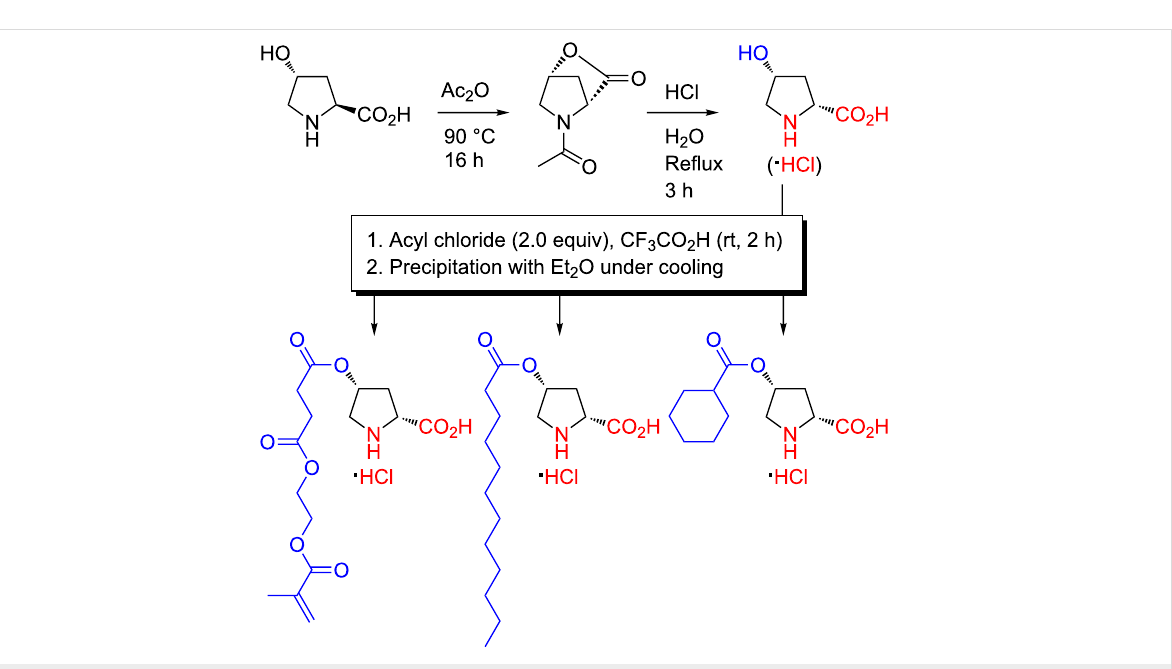
place during those experiments. The literature of such early experimentation on amino alcohol natural products is too volu- minous to justify any exhaustive listing in this work, thus for the purposes herein, it will suffice to point out that the outcome of acetylation reactions on such amino alcohols varied greatly depending on the acidity or alkalinity of the reaction